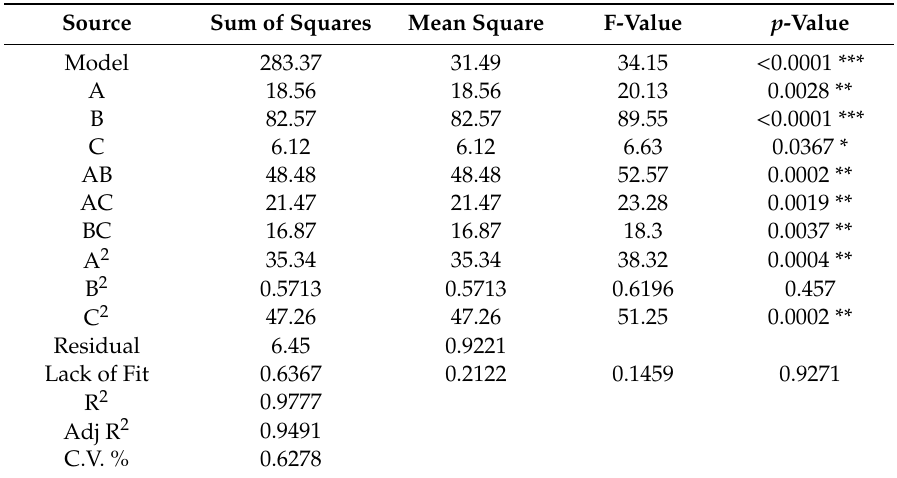
Table 2. The variance analysis of regression model.